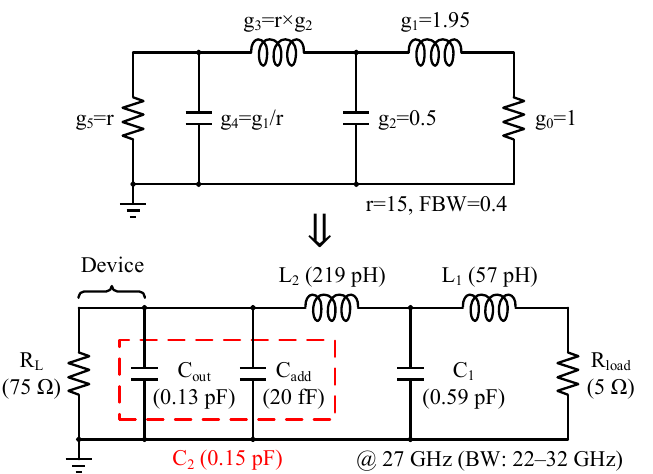
Figure 9. Conversion from a 0.1 dB equal-ripple low-pass filter prototype to a denormalized network.